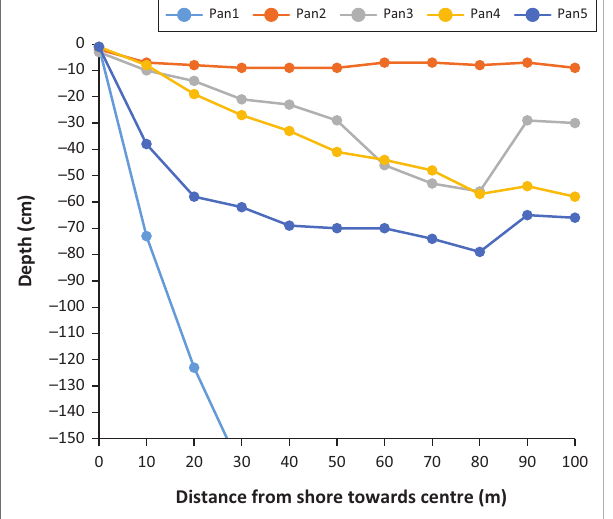
FIGURE 3: Depth in cm from the edge of the pan up to 100 m towards the centre of the pans in April 2019, where Pans 2 and 3 were in the savanna biome and Pans 1, 4 and 5 in the Nama-Karoo